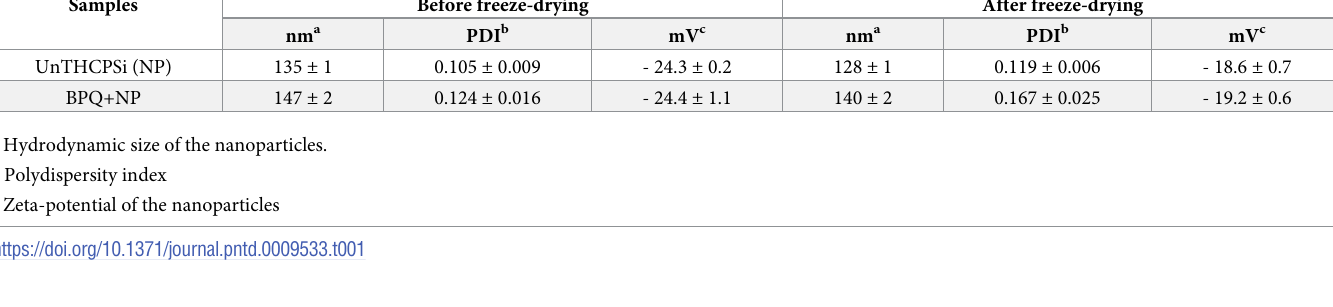
Table 1. Results of DLS measurements of the nanoparticles before and after freeze-drying (mean ± σ , n = 3). Samples Before freeze-drying After